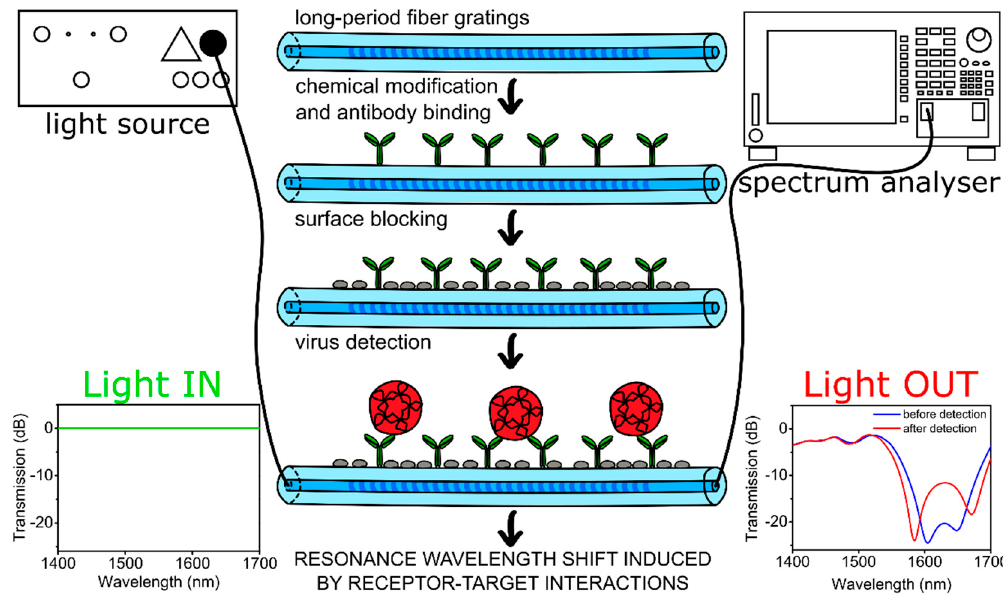
Figure 1. Schematic representation of the experimental setup and fiber surface modification steps leading to norovirus detection. The modifications take place over the whole circular surface of the fiber.